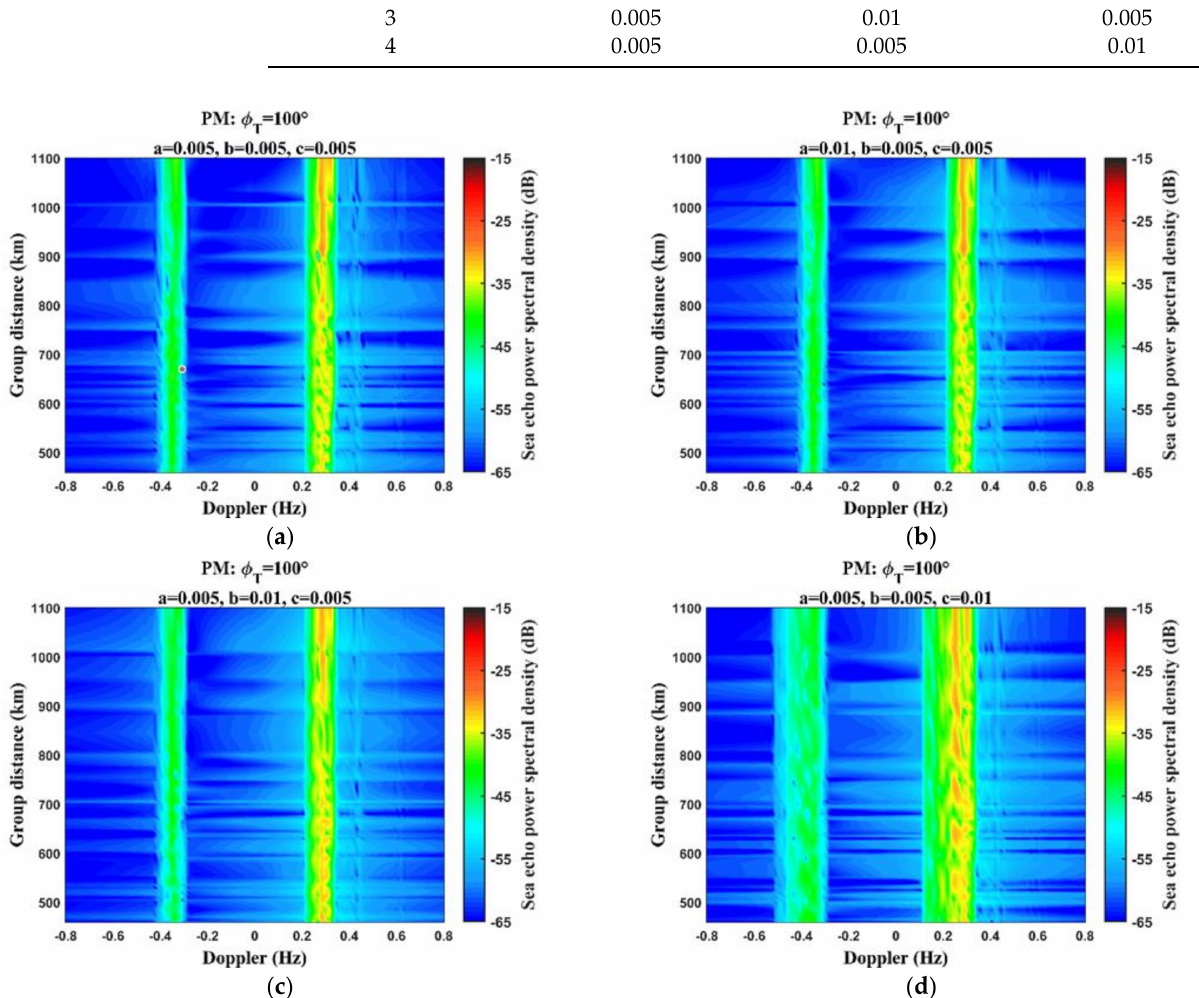
Figure 8. Simulation results for the presence of ionospheric phase contamination in Figure 7b. The ionospheric phase contamination was calculated using Equation (11) and the coefficients ( a , b , c ) shown in Table 4. ( a ) a = 0.005, b = 0.005 and c = 0.005. ( b ) a = 0.01, b = 0.005 and c = 0.005. ( c ) a = 0.005, b = 0.01 and c = 0.005. ( d ) a = 0.005, b = 0.005 and c =